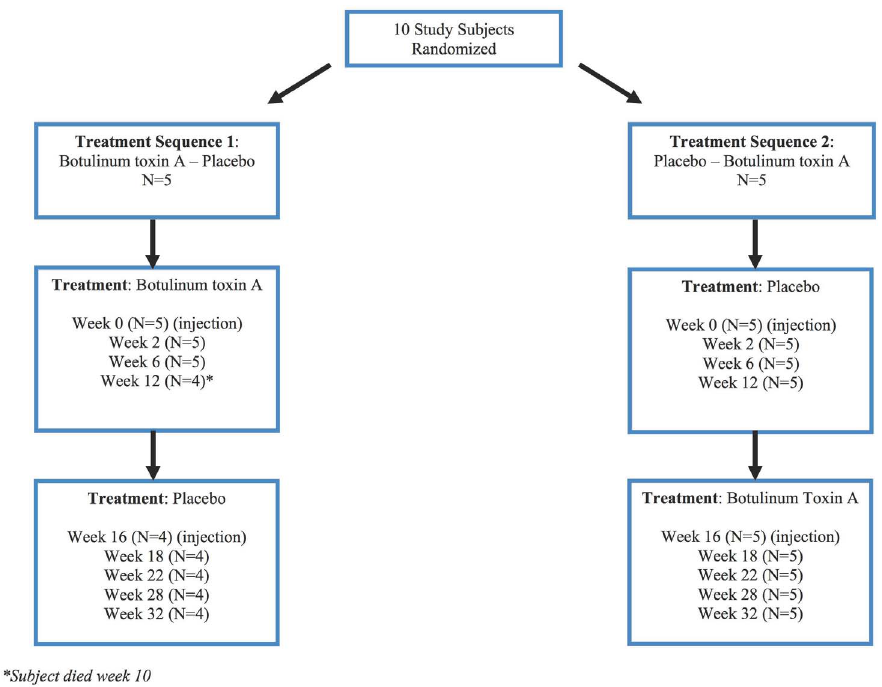
Fig. 1. Study flow